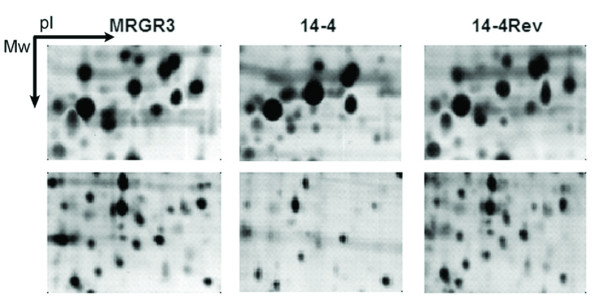
Two windows for each strain are represented to illustrate 2-D gel electrophoresis performed on membrane-enriched protein fractions of GISA (14-4) and glycopeptide-susceptible strains (MRGR3 and 14-4Rev). While similar patterns are observed between susceptible strains, drastic differences are visible when comparing the GISA with either of the susceptible strains.